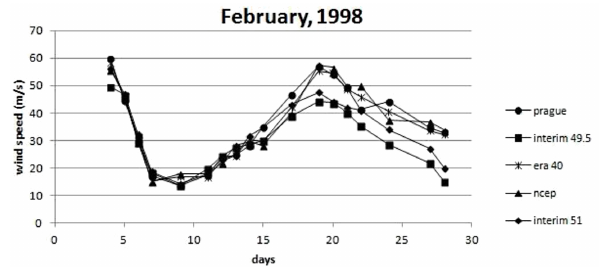
Fig. 6. Time development of ERA-40, NCEP (50 ◦ N, 15 ◦ E), ERA- Interim (51 ◦ N and 49.5 ◦ N, 15 ◦ E) and Prague-Libus wind speeds for February 1998 at